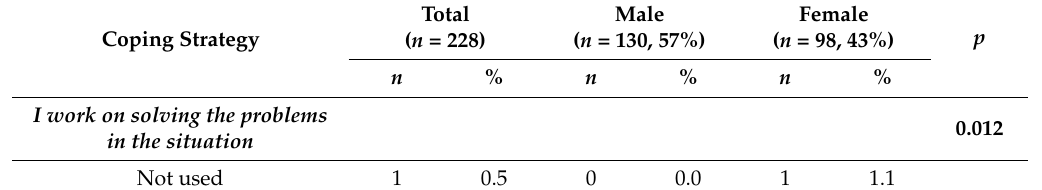
Table 3. Frequency of coping style strategy stratified by